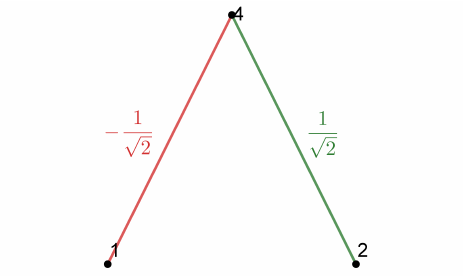
Figure 9. Clifford torus representation as a submanifold of S 3 ( 1 )